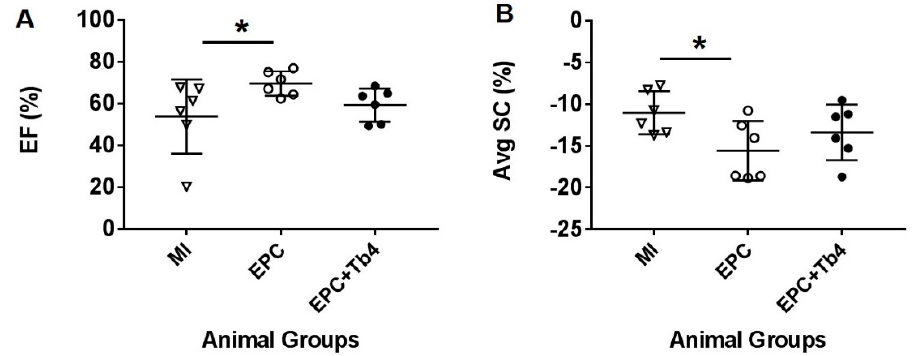
Figure 3. Dot-plot of ejection fraction (EF) ( A ) and average myocardial circumferential systolic strain (AvgSc) ( B ) of each rat in the MI, EPC, and EPC + Tb4 Groups. (One-way ANOVA, * p < 0.05).